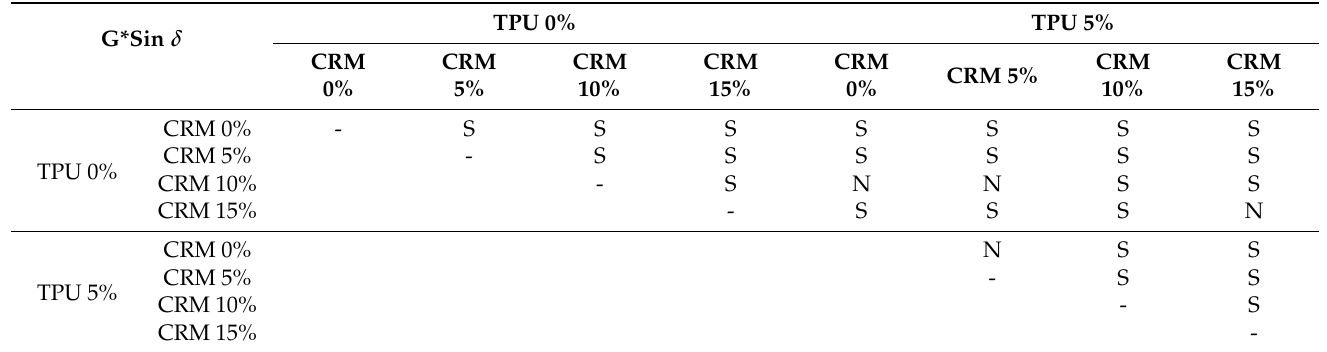
Figure 10. G* · sin δ of the asphalt binders containing CRM and TPU for RTFO + PAV condition. Table 9. Statistical analysis results of the G*sin δ as a function of CRM contents and the addition of TPU ( α =